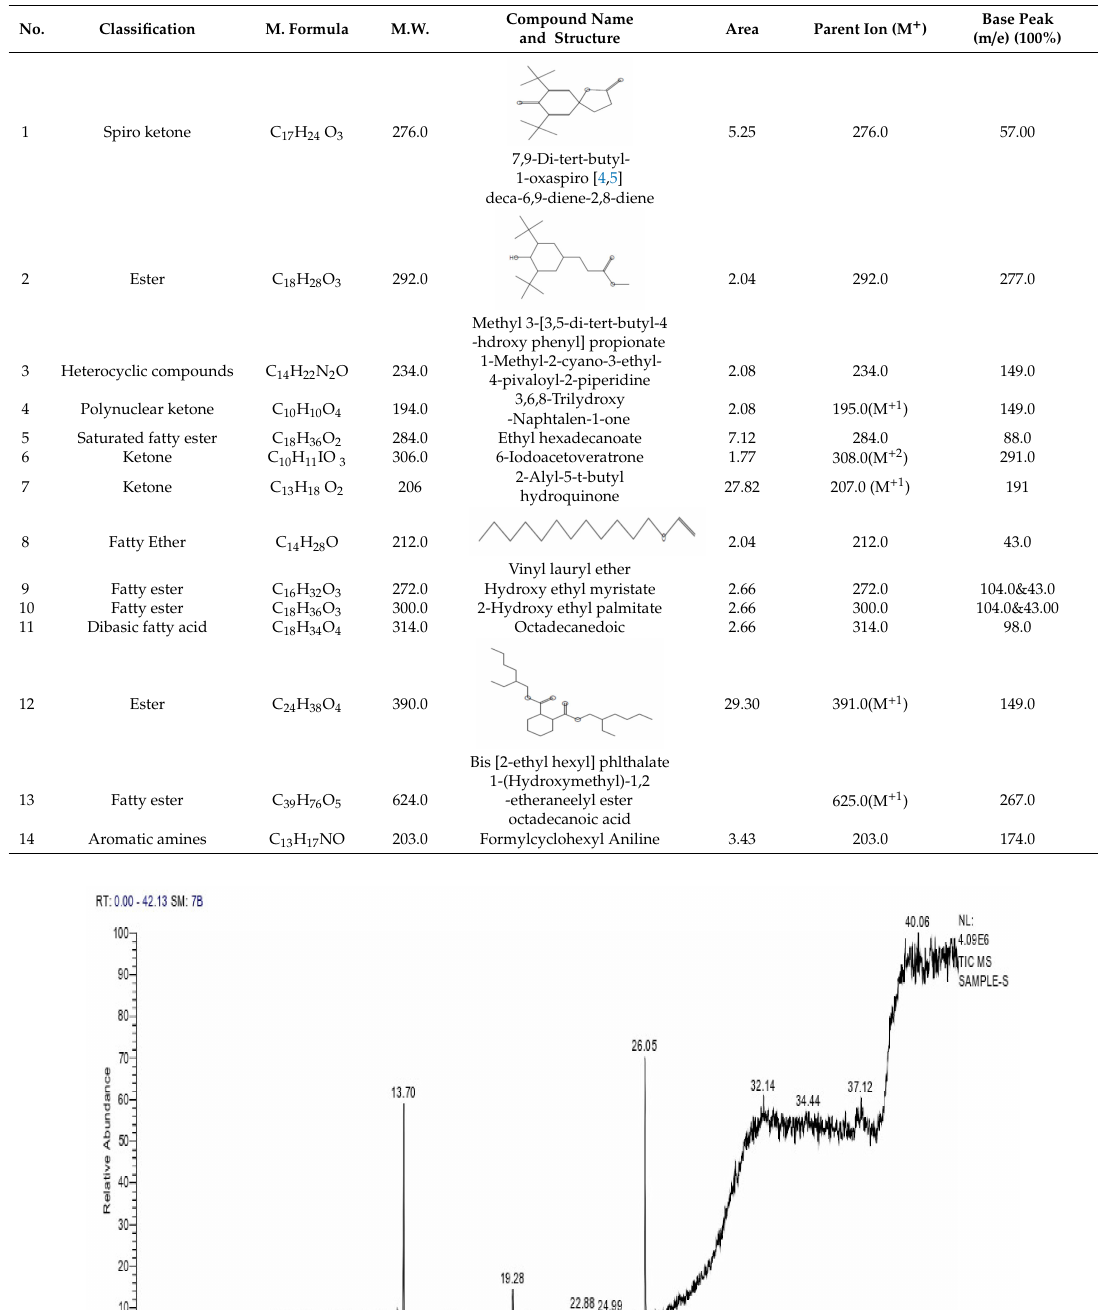
Table 4. Putative identification of 14 components from MSE when subjected to GC-MS (gas liquid chromoatographic mass spectrometry).